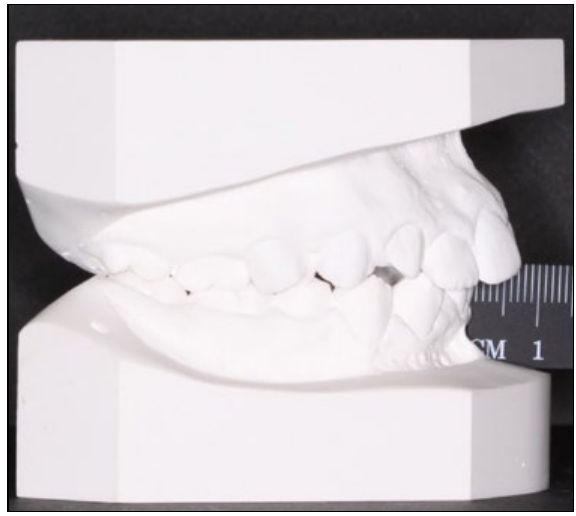
Figure 4. MM ruler to measure the